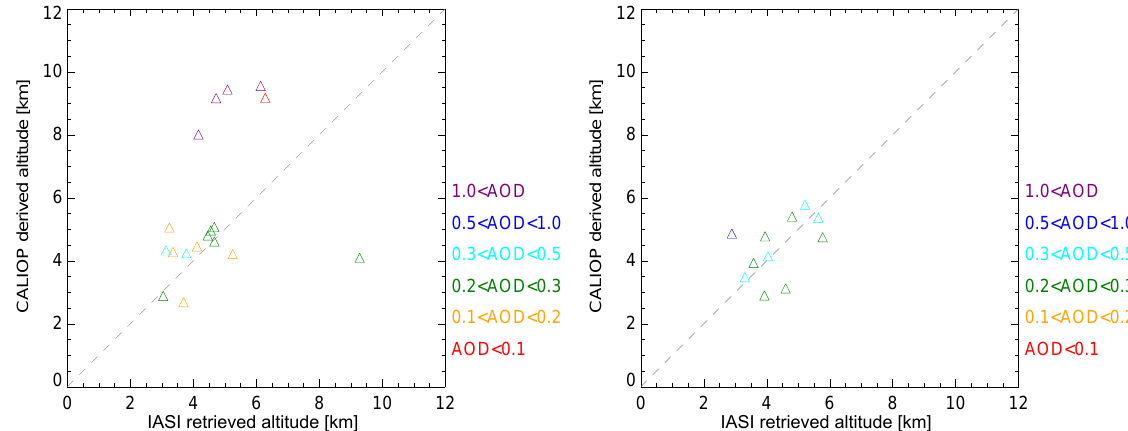
Figure 9. The results of comparisons between the retrieved IASI altitude and the derived CALIOP plume height for the Eyjafjallajökull eruption on 6 and 11 May